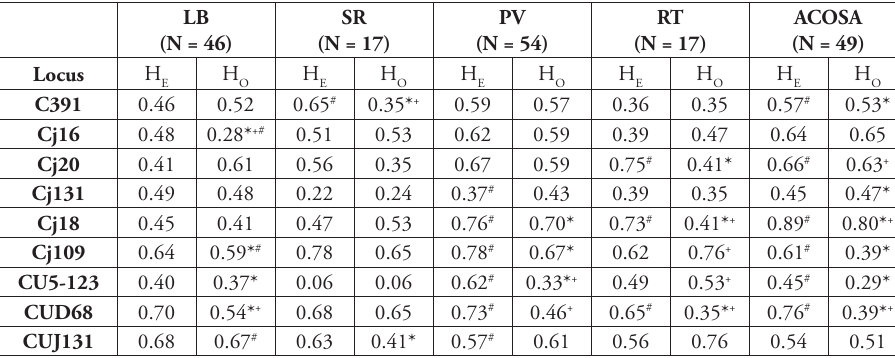
) for microsatellite loci in Crocodylus acutus O